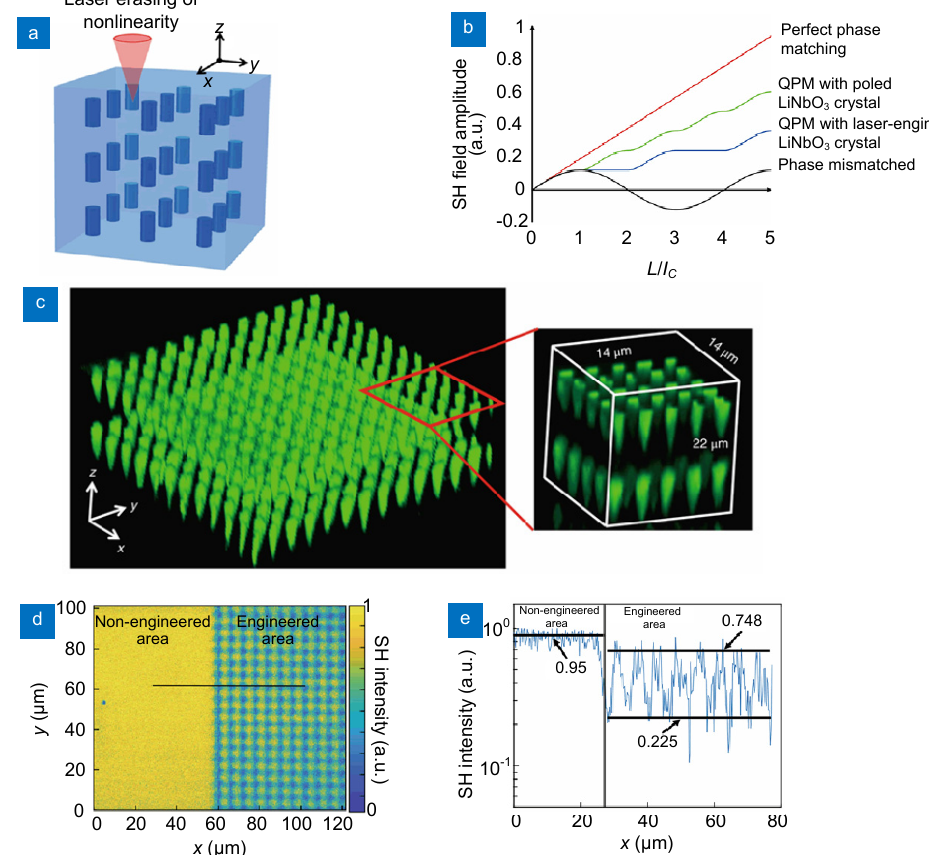
Fig. 1 | Laser induced refractive index change for fabrication of photonic crystals in LiNbO 3 . ( a ) Schematic diagram. ( b ) The relationship of the amplitude of second-harmonic and the phase-matching mechanism. ( c ) and ( d ) Second-harmonic confocal microscopy image of the 3D pho- tonic crystal and which in X - Y plane. ( e ) Intensity distribution along the black line in (d). Figure reproduced from ref. 44 , Springer